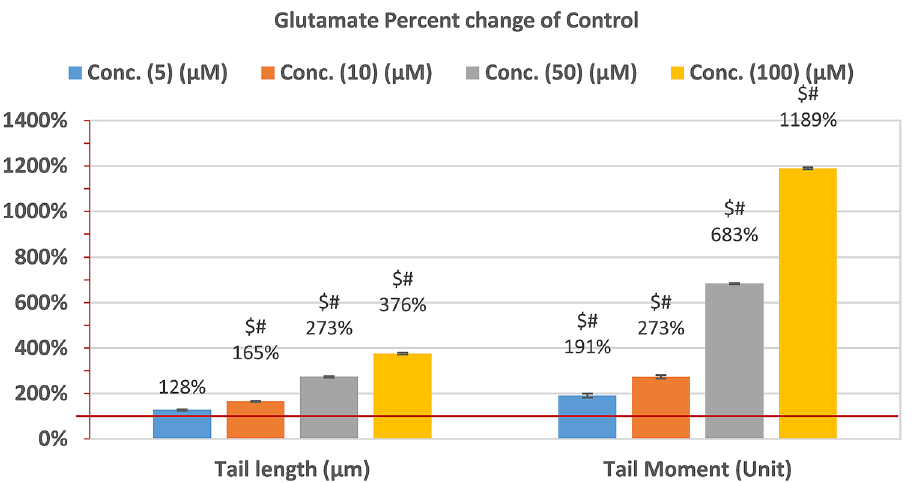
Figure 2. Percentage change of tail length and tail moment in glutamate-intoxicated RGCs compared to healthy untreated control